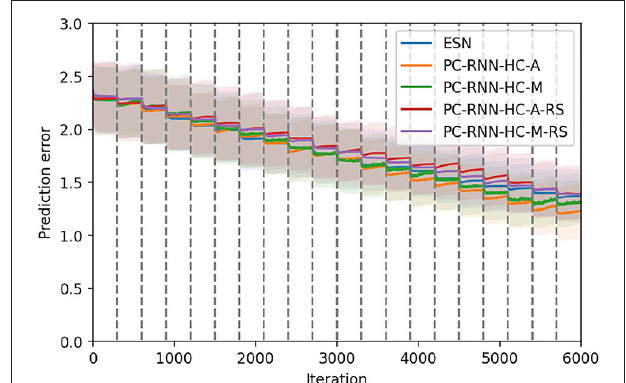
FIGURE 9 | PC-Conceptors model.